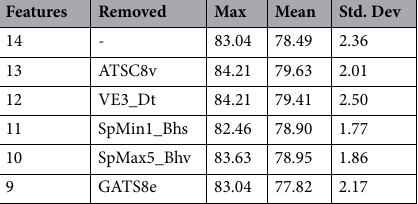
Table 3. Toxicity Dataset, maximum, mean, and standard deviation of 10-Fold CV accuracies with 100 repetitions. DTC applied to reduced feature sets obtained by removal of a single feature at a time.